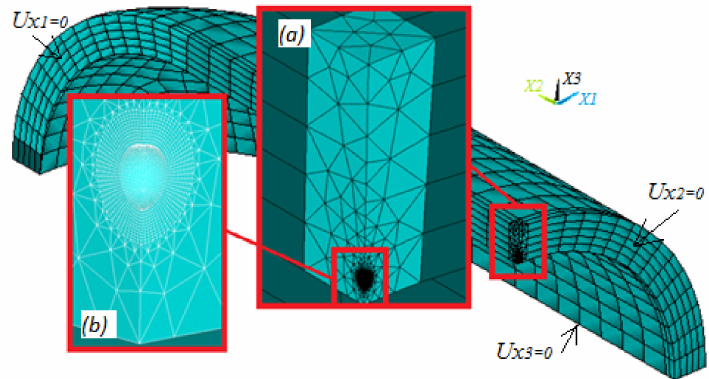
Figure 5. A typical mesh in the pipe containing a spherical cavity: ( a ) depth of the flaw on the thickness of the cylinder and ( b ) magnification of the area occupied by the spherical